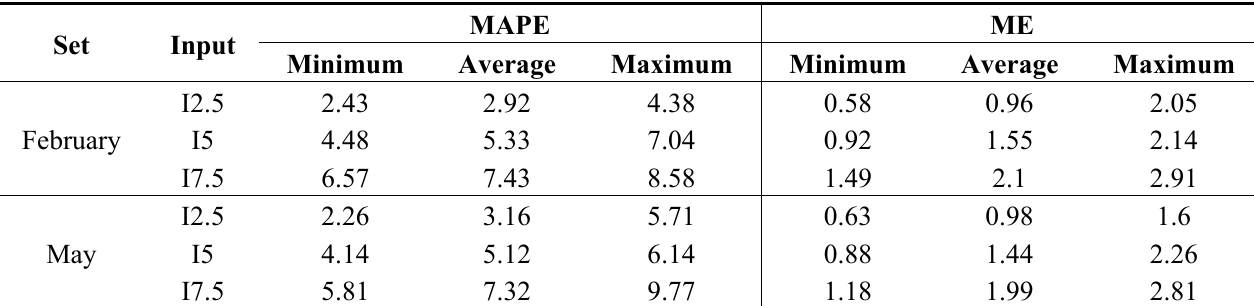
Table 2. Average, max and min daily MAPEs and MEs, obtained with artificial inputs during Stage